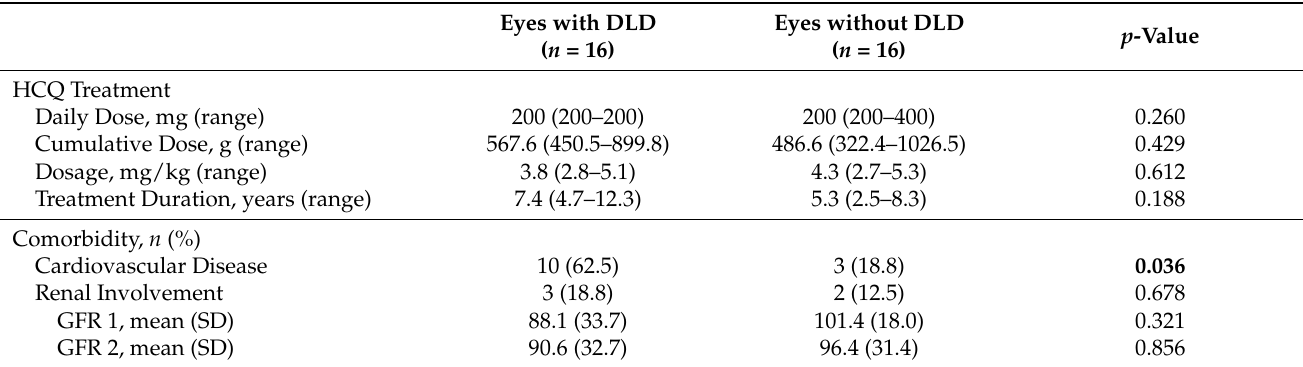
Table 2. HCQ treatment characteristics and prevalence of relevant comorbidities. Significant differ- ences shown in bold type. SD, standard